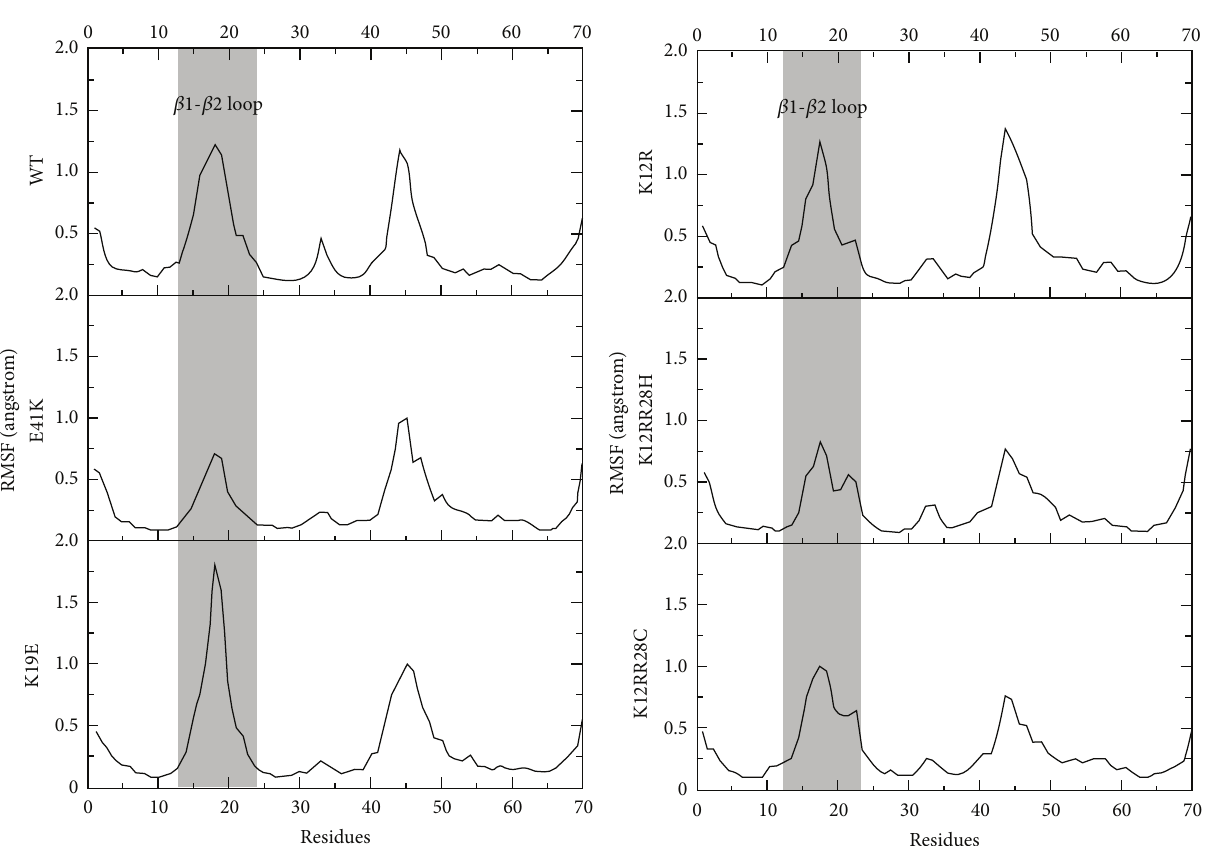
Figure 4: Residue fluctuations obtained by average residual fluctuations between residues 1 and 70 for six simulations, wild type (WT), K19E, E41K, K12R, and K12R-R28C/H, over the 20 ns simulations are illustrated in solid lines. The residues of 𝛽 1- 𝛽 2 loop are